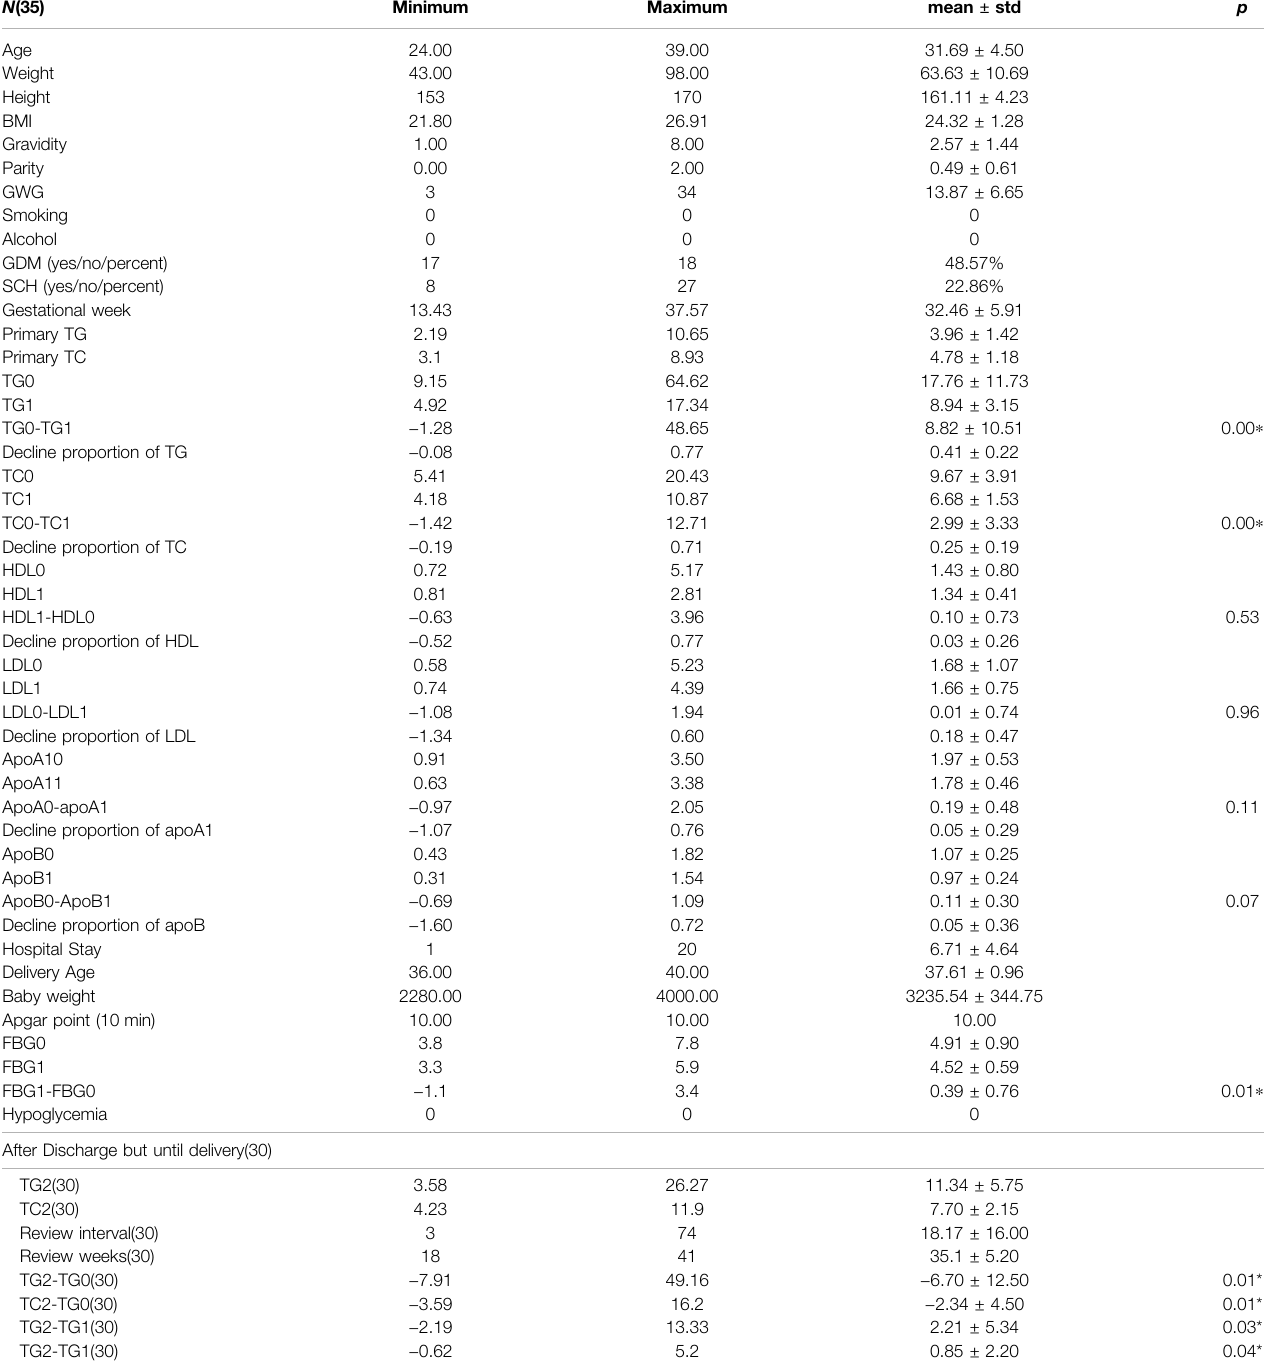
TABLE 1 | Characteristics of enrollment of 35